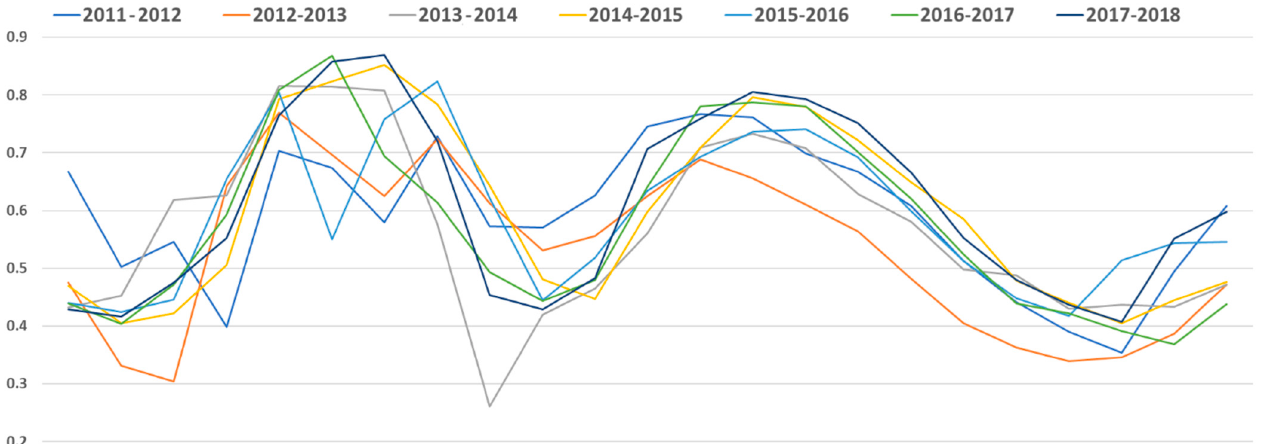
Figure 7. Inter ‐ annual variability of the mean NDVI time series of the iCL class samples over Mato Grosso, for seven agricultural campaigns: 2012/2013, 2013/2014, 2014/15, 2015/16 (ENSO), 2016/17, 2017/18 and 2018/19 (ENSO). 5.2.2. Impact of the Temporal Training Strategy on the Classification Performances In Figure 8, the results show that the overall accuracy and the F ‐ score of the iCL class are higher for strategy (b), with pooled annual samples than for strategy (a), with individual annual samples. This is particularly true for years with small sample datasets, such as 2012/2013, 2013/2014 and 2018/2019. For years with large samples datasets (2015/2016, 2016/2017 and 2017/2018), the overall precision and the F ‐ score have little variation; regardless of the number of years used for training. The results suggest that the classification accuracy is more related to the number of training samples than to the inter ‐ annual variability of the precipitation.